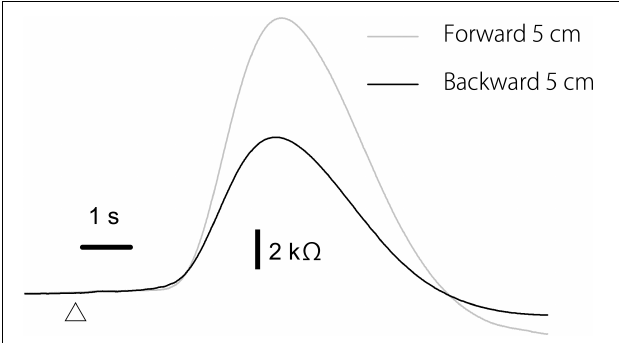
FIGURE 5 | Averaged traces of the EDR across 10 trials in the block testing the effect of the translation direction in a participant.